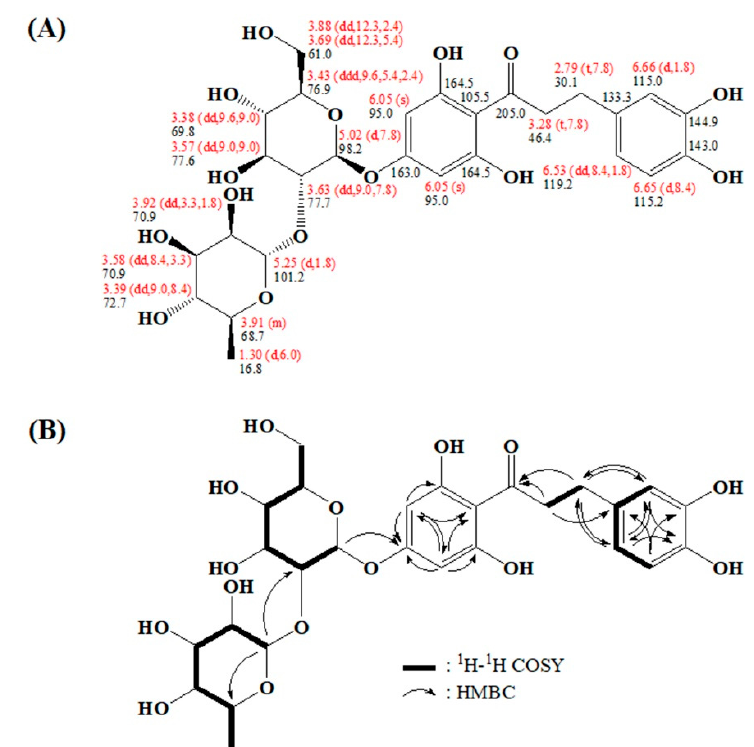
Figure 7. ( A ) Chemical structure of the major product (neoeriocitrin DC) from naringin DC. Red: 1 H chemical shift values (multiplicity and coupling constants [Hz] in parenthesis); Black: 13 C chemical shift values which were assigned from 2D HMBC NMR spectra. ( B ) 2D NMR spectra of the major product, neoeriocitrin DC. (See also Supplementary Figure S1-S3 for NMR spectra.)